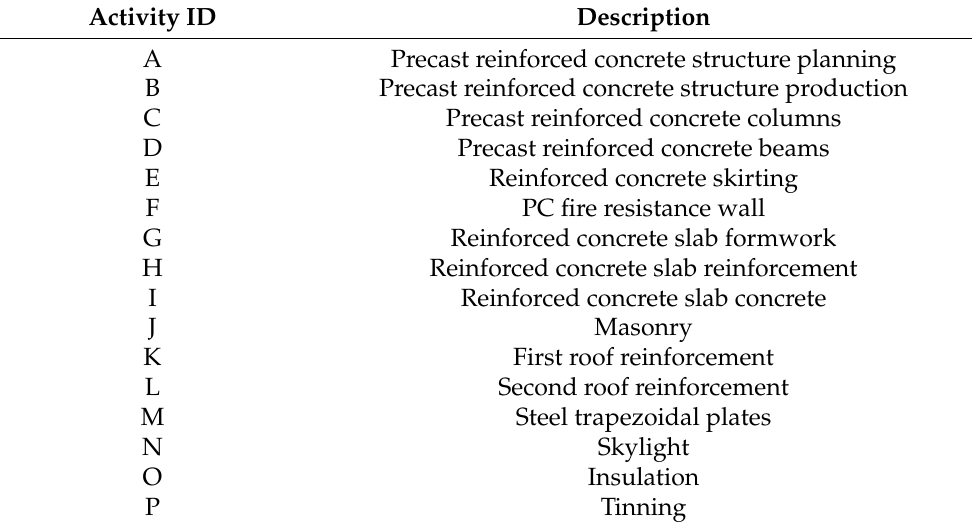
Table 1. Construction phase